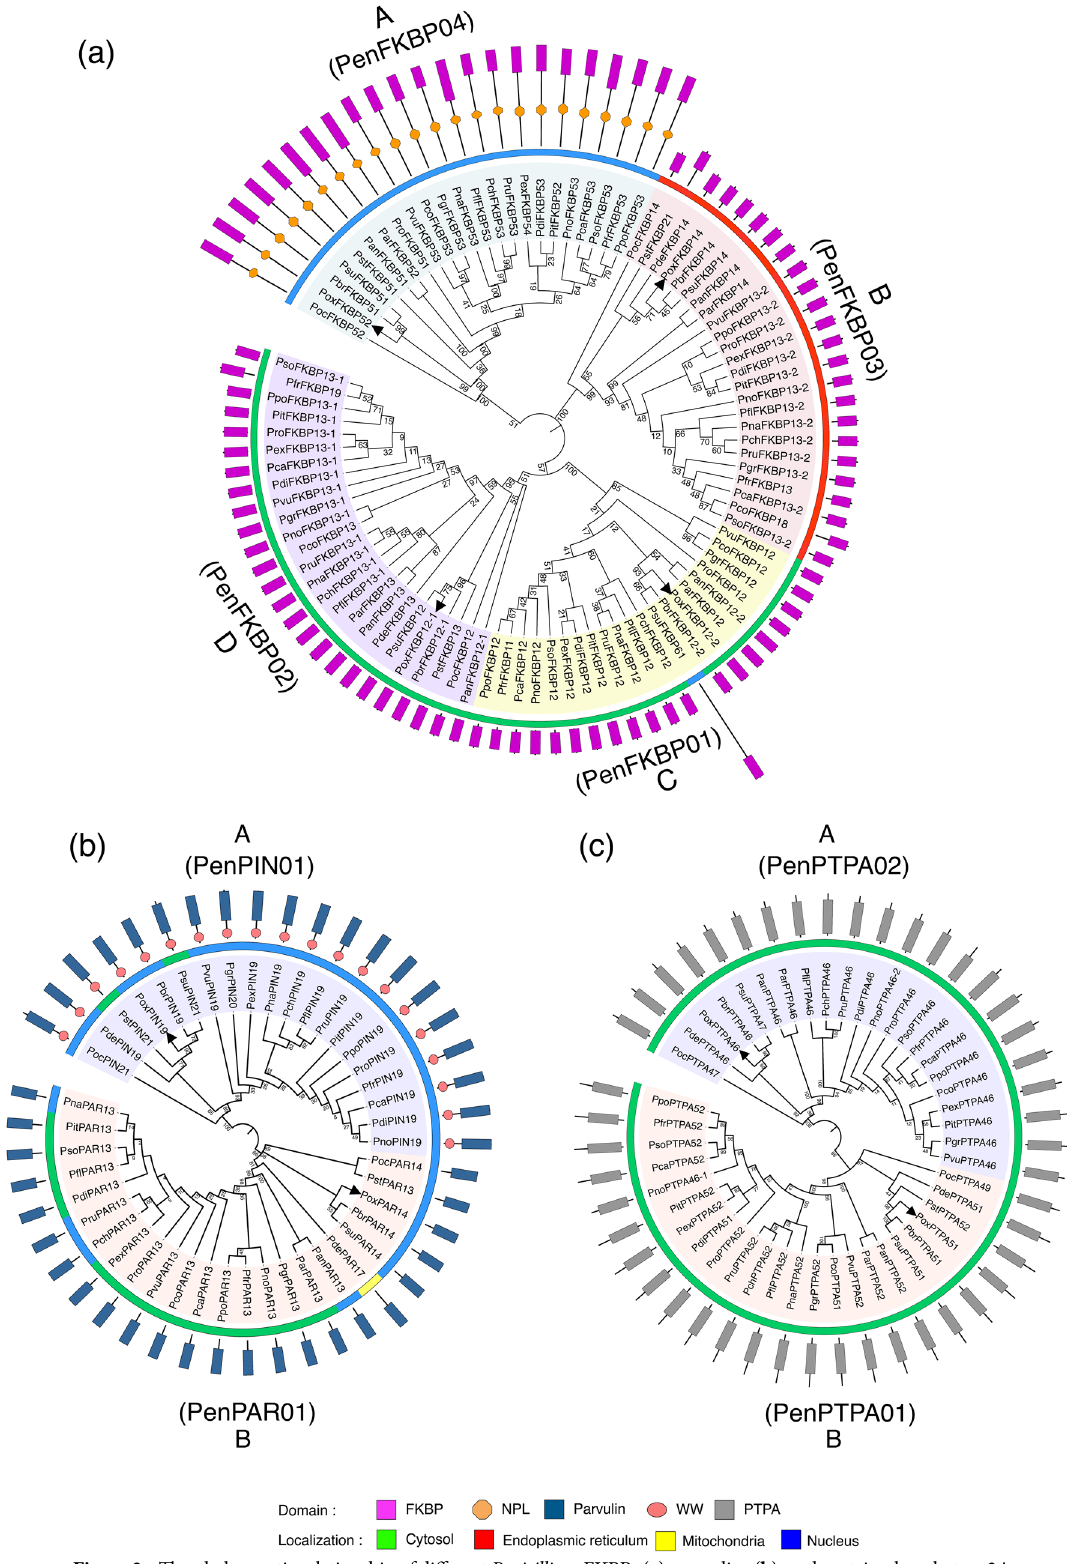
Figure 3. The phylogenetic relationship of different Penicillium FKBPs ( a ), parvulins ( b ), and protein phosphatase 2A phosphatase activators (PTPAs) ( c) . The unrooted tree was generated using the neighbor-joining method in MEGA X (v10.1.7) software (http:// www. megas oftwa re. net). The constructed trees were further annotated with the Iterative Tree of Life (http:// itol. embl. de/) and redrawn by using Adobe Illustrator (v25.2.3) (https:// adobe. com/ produ cts/ illus trator). Bootstrap values from 1000 replicates are indicated at each branch. Localization of each member is represented in different colors. Domain architecture of each protein is also depicted in the outermost layer. Black triangles represent the Penicillium oxalicum